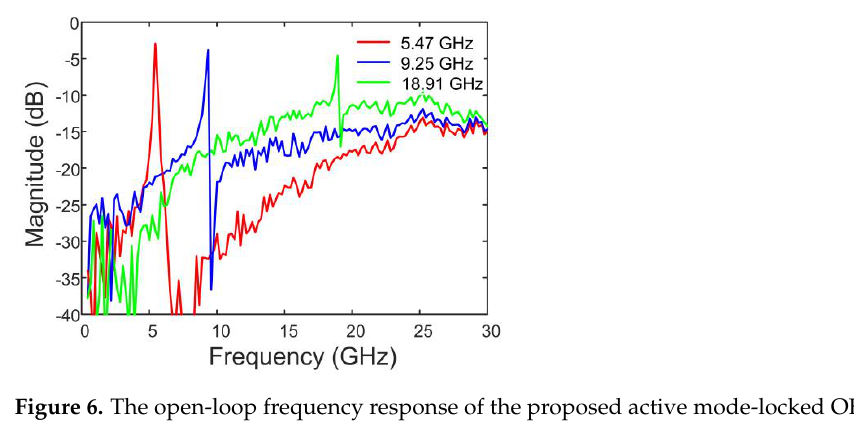
Figure 6. The open-loop frequency response of the proposed active mode-locked OEO at different central frequencies.